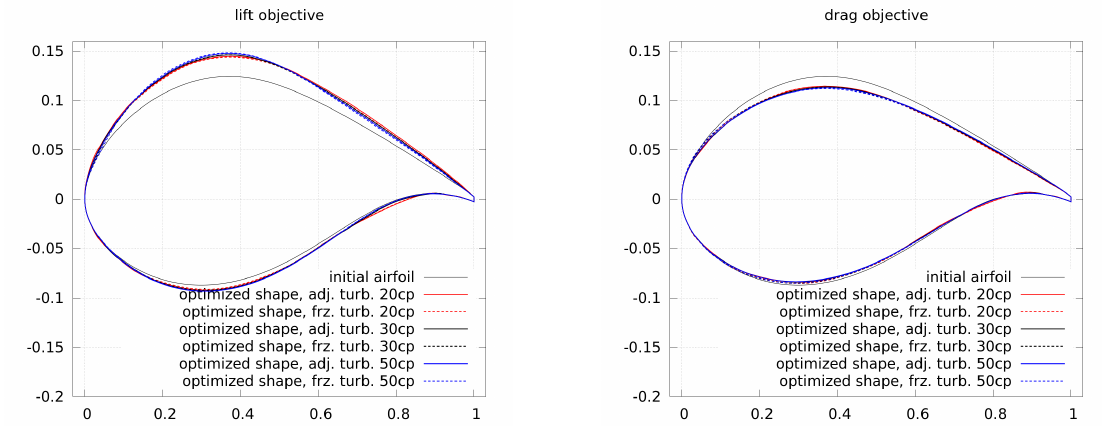
Figure 15. Airfoil shapes using adjoint and frozen turbulence for the lift and drag objective for DU 93-W-210 at AoA = 2 ◦ . Frozen as well as adjoint turbulence are used. The number of control points is labeled as “XXcp”.